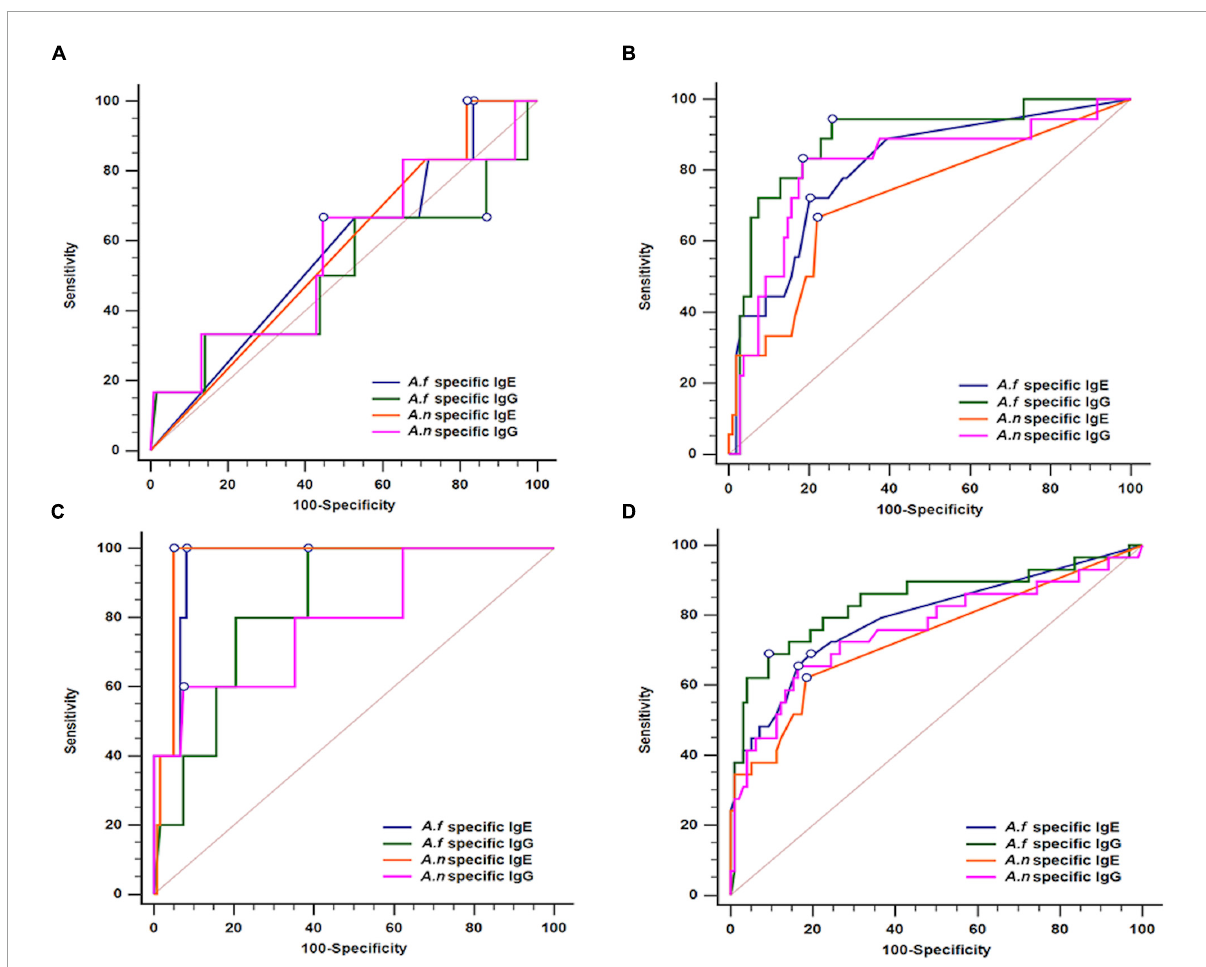
FIGURE1 Receiver operating characteristic curve (ROC) analyses of Aspergillus fumigatus - and Aspergillus niger -specific IgG and IgE for the diagnosis of (A) Invasive aspergillosis, (B) chronic pulmonary aspergillosis, (C) allergic bronchopulmonary aspergillosis, and (D) all of the above; A. f , Aspergillus fumigatus ; A. n , Aspergillus niger